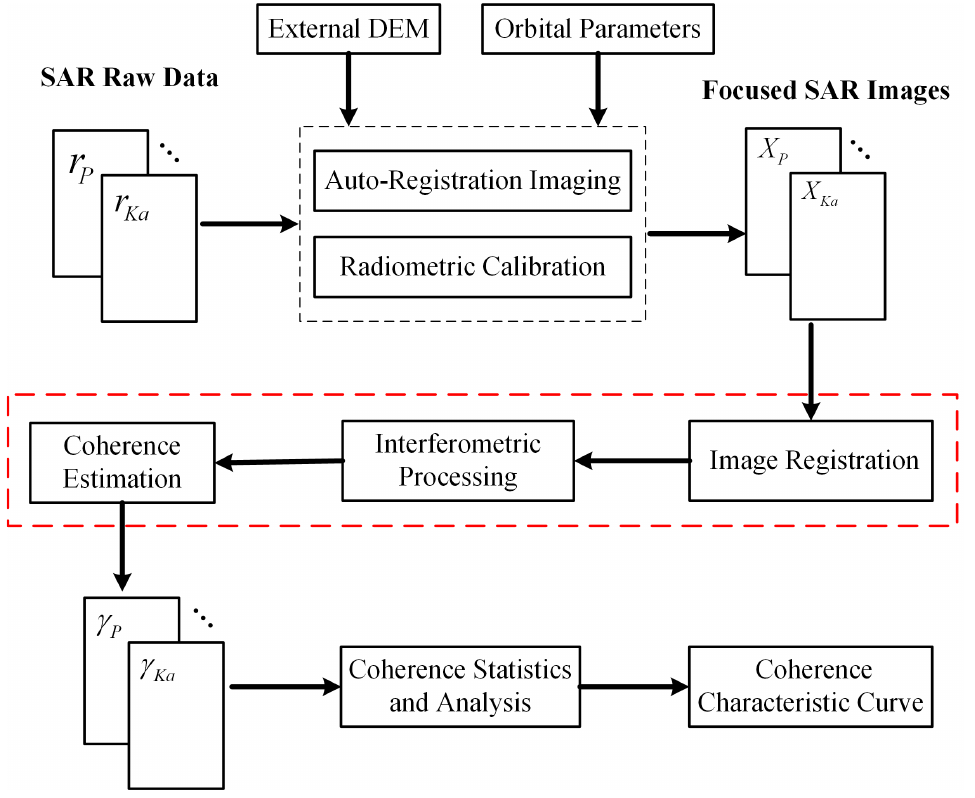
Figure 1. The whole process of the multi-frequency interferometric coherence characteristics analysis of typical objects for coherent change